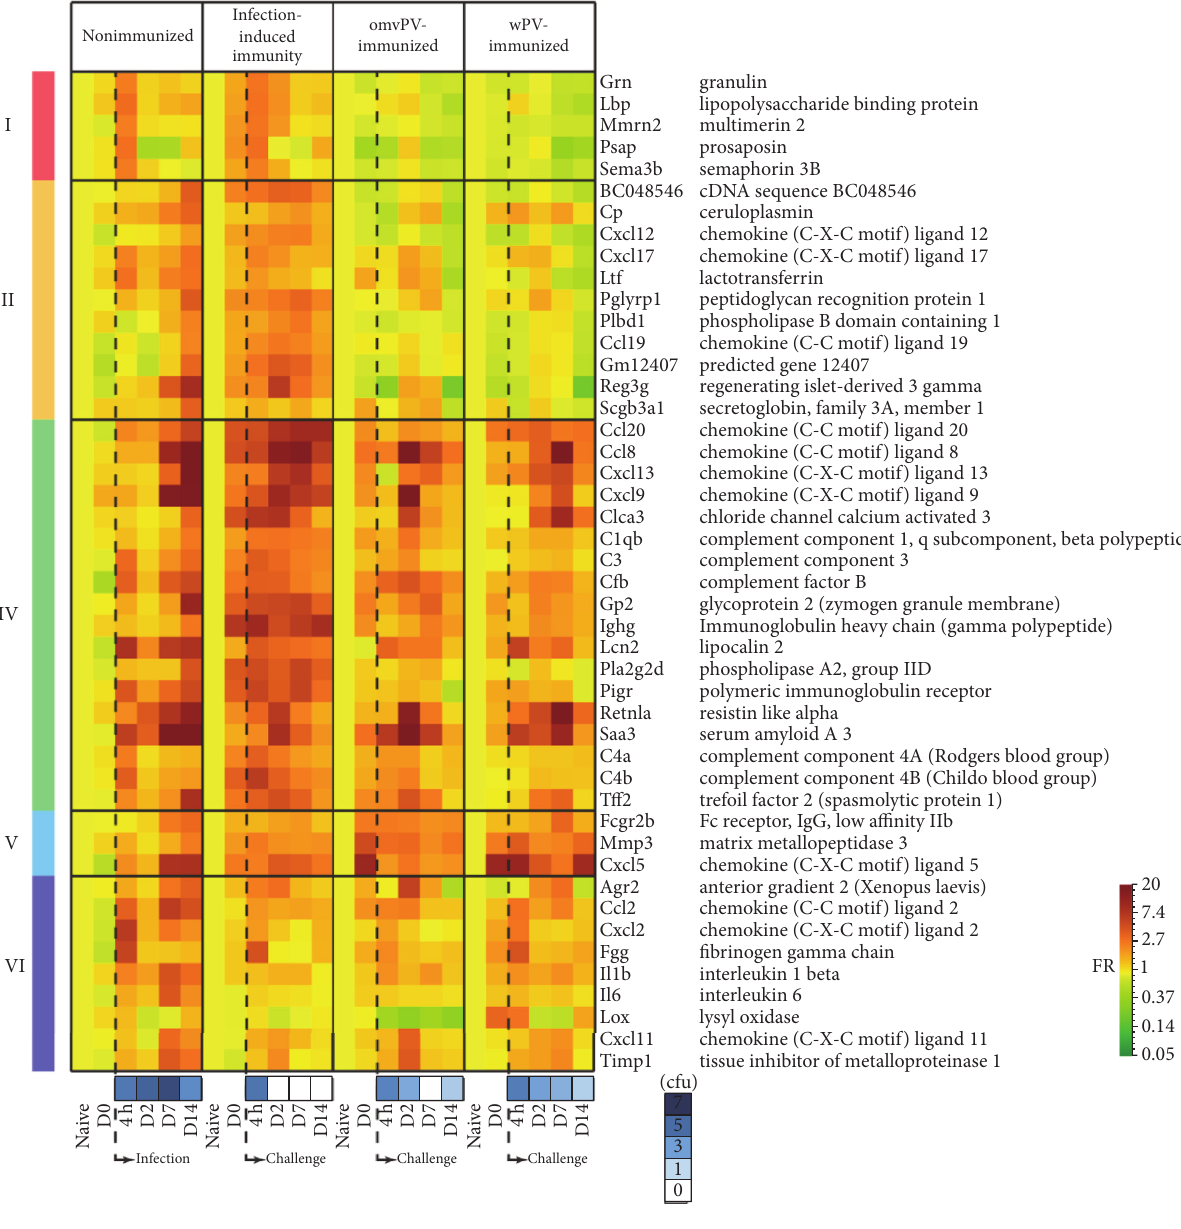
Figure 5: Genes encoding for secreted proteins. Genes encoding for secreted proteins were retrieved from DAVID and illustrated as heatmap for the four pulmonary transcriptome datasets. The genes are clustered according to prevalence in the six function groups (I–VI), which is shown on the left. The moment at which the B. pertussis infection or challenge was performed is depicted as well as the log10 number of colony forming units (cfu) for each time point postchallenge as determined previously [7,